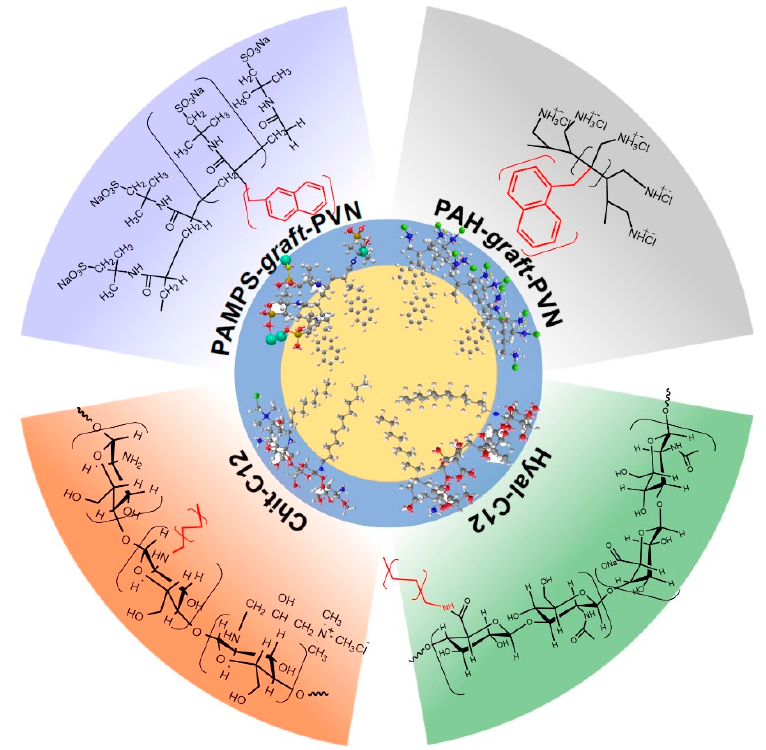
Figure 2. Nanocapsules stabilized by graft amphiphilic polymers and hydrophobically modified polysaccharides developed by Zapotoczny et al.